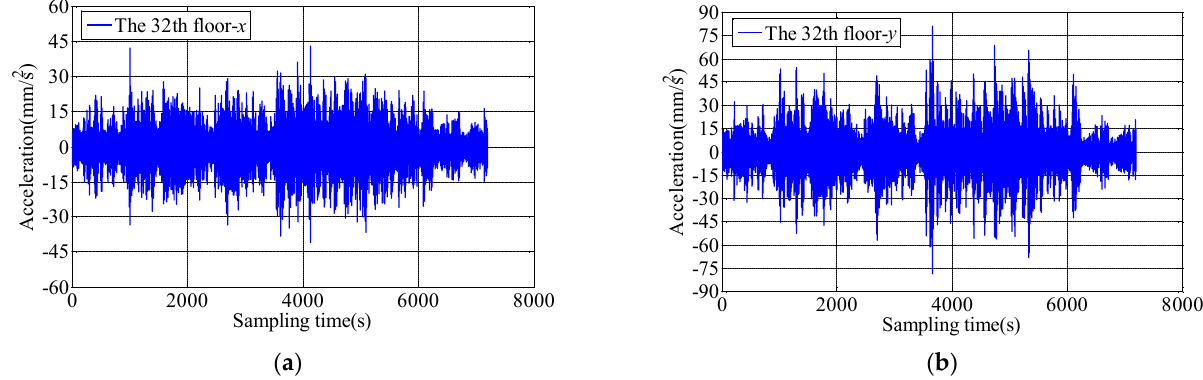
Figure 5. Time history of acceleration response on 32th floor during Typhoon Sarika. ( a ) 32nd floor along x axis; ( b ) 32nd floor along y axis.